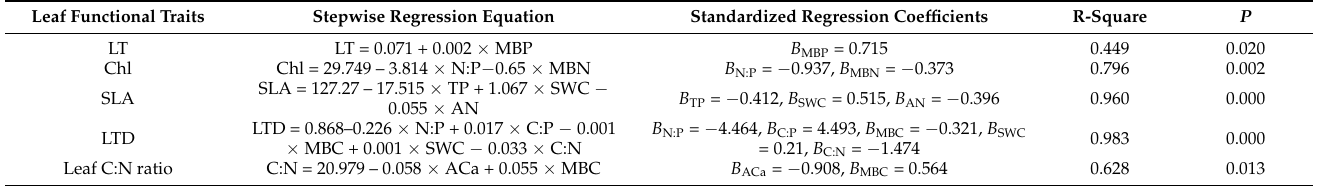
Table 7. Stepwise regression analysis of leaf functional traits and soil